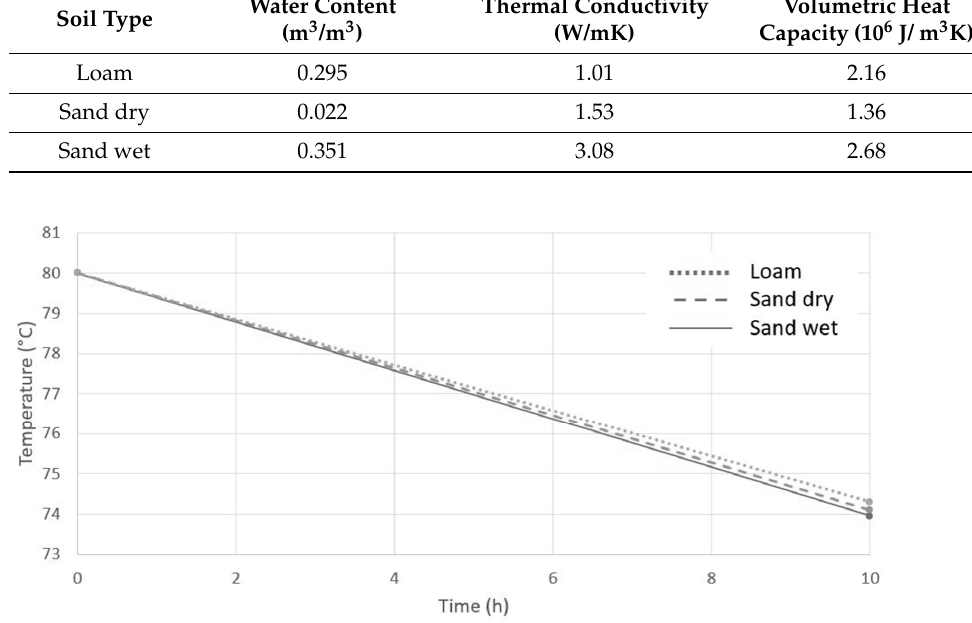
Figure 4. Illustration showing the small effect of different soil types on cooling time; MATLAB FDM model.